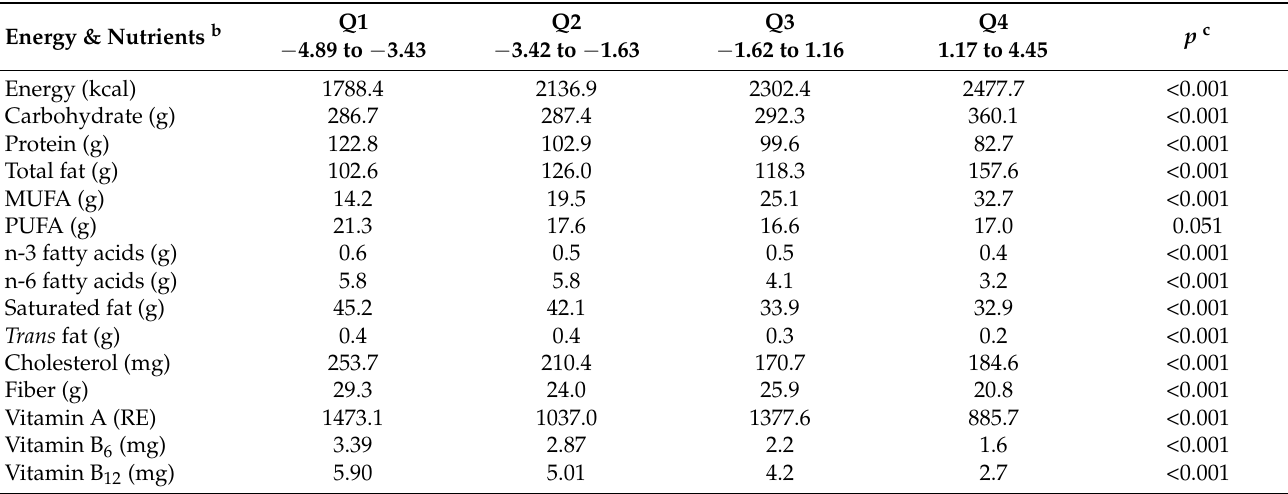
Table 2. Dietary energy and nutrient intake across E-DII quartiles of Ecuadorian women participants ( n = 276) a